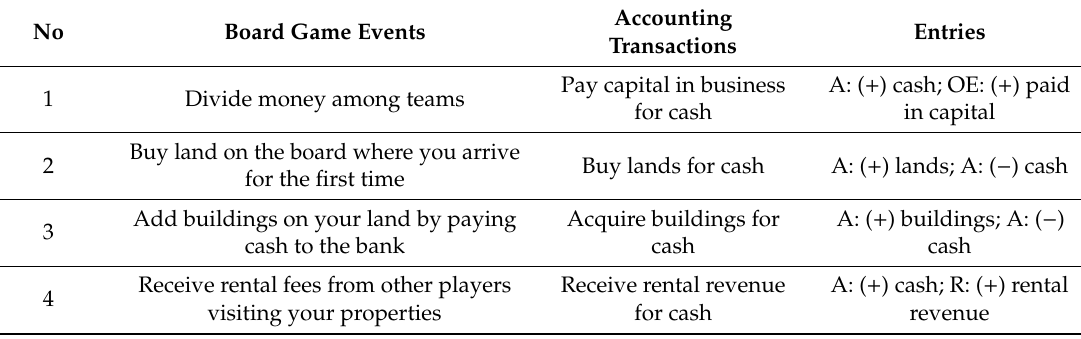
Table 1. Recording transactions on the worksheet in the board